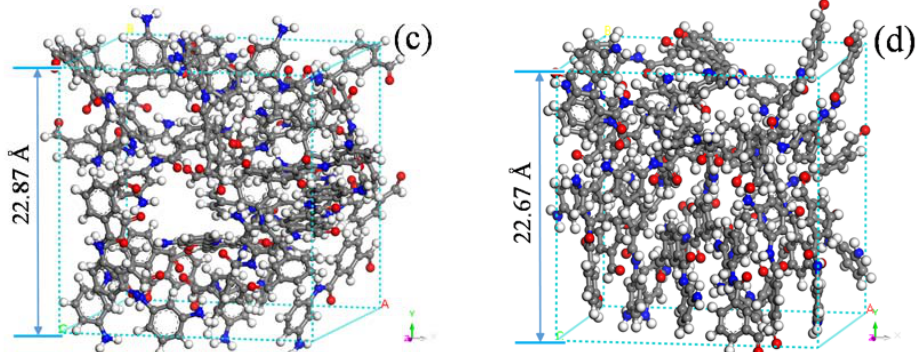
Figure 2. Models of meta-aramid fiber before and after optimization: ( a ) initial 3-PMIA model, ( b ) optimized 3-PMIA model, ( c ) initial 30-PMIA model, ( d ) optimized 30-PMIA model.